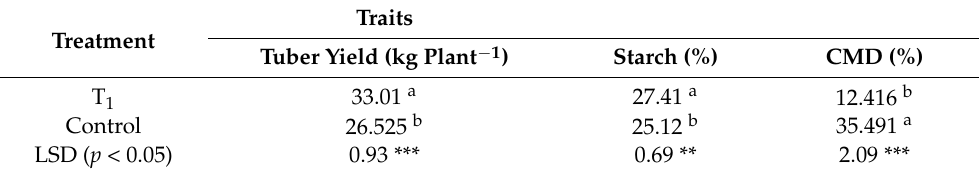
Table 8. Effect of combined nutrient/biocontrol agent mixture spray on tuber yield (kg plant − 1 ), starch (%), and CMD (%) of cassava. Each data point is an average of 20 independent trials conducted at different locations ( n = 60). Means followed by the same letter are not statistically significant at p < 0.05.